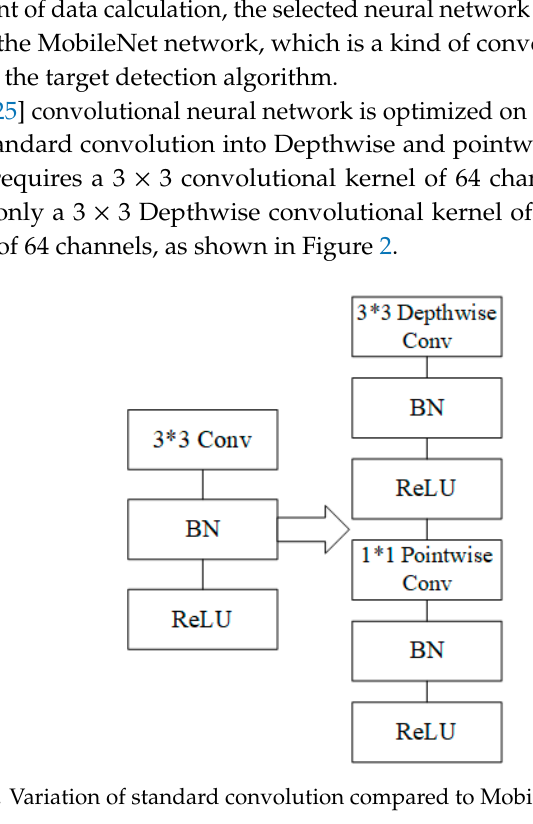
Figure 1. The data processing flow between Geographic Information System for Transportation (GIS- T) and the traffic congestion monitoring system.